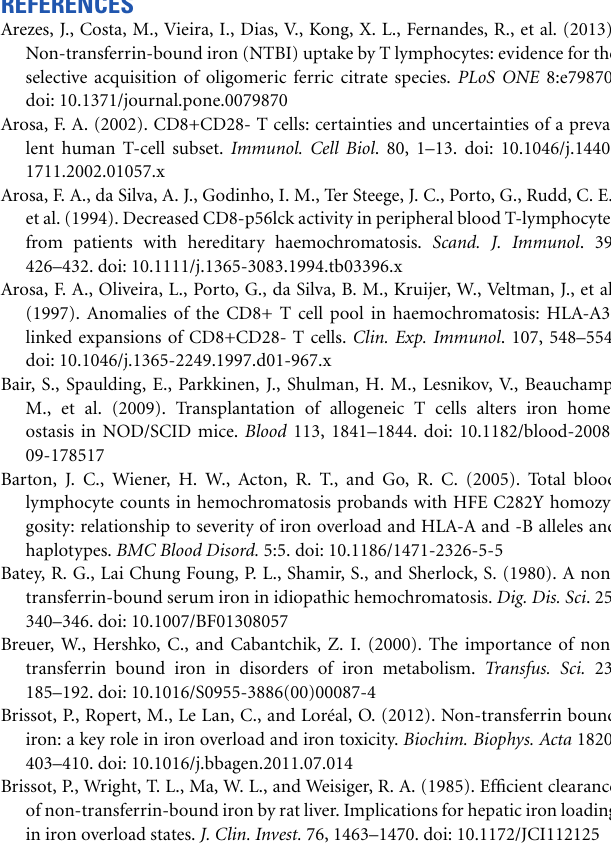
Supplementary Figure 1 | Assessment of the purity of the plasma membrane fraction from human CD3 + cells. Membrane (M; n = 1), cytoplasmic (C; n = 3), and total (T; n = 1) protein fractions from human CD3 + cells were blotted and the membrane incubated with the plasma membrane marker anti-alpha 1 Na/K ATPase antibody. Supplementary Figure 2 | Effect of NTBI on FPN1 mRNA expression in human peripheral blood T lymphocytes. qRT-PCR analysis of FPN1 mRNA expression in human peripheral blood CD4 + and CD8 + T lymphocytes incubated with 5 μ M Fe-citrate or PBS for up to 6h. Data are depicted as fold change relative to FPN1 mRNA levels at 0h for each cell population. Experiments were performed three times with 2 replicates per experiment. Each bar represents the mean ± 1 SD. Supplementary Figure 3 | Effect of hepcidin on Fe-citrate uptake by T lymphocytes. Intracellular 55 Fe levels in CD4 + and CD8 + T-lymphocytes incubated with 5 μ M of 55 Fe-citrate, for 30min, in the presence of 100 or 600ng/ml of human synthetic hepcidin. Mock controls were incubated without hepcidin. Experiments were performed three times with 3 replicates per experiment. Each point represents the mean ± 1 SD. Supplementary Figure 4 | Effect of T lymphocyte reconstitution on Hamp1 mRNA expression on Foxn1 nu mice. qRT-PCR quantification of Hamp1 mRNA expression on livers of Foxn1 nu mice on iron-rich (+NTBI) or iron-sufficient (no NTBI) diets I.V. injected with 15 × 10 6 CD3 + T lymphocytes or with PBS (Mock). Data are depicted as fold change relative to FPN1 mRNA levels of Mock animals on iron-sufficient diet. Each bar represents the mean ± 1 SD of the values obtained for three animals. Statistical analysis was performed using One-Way